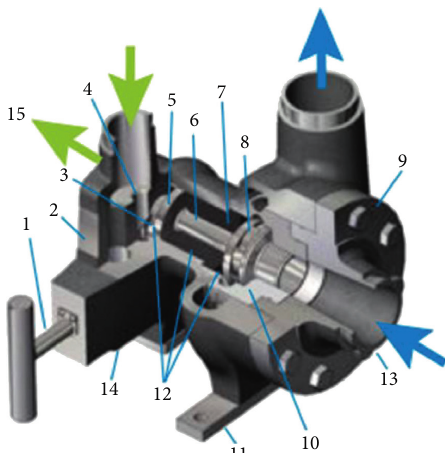
Figure 2: ERT model. (1) Flow control valve for concentrated brine; (2) signage; (3) thrust bearing; (4) single vortex design of brine pipe; (5) turbine impeller blades; (6) rotor shaft; (7) flow path of hydraulic thrust bearing center; (8) impeller of booster pump; (9) single-ended blind; (10) pump volute; (11) base; (12) seal ring; (13) inlet of integral machine; (14) standard material; (15) outlet of integral machine.